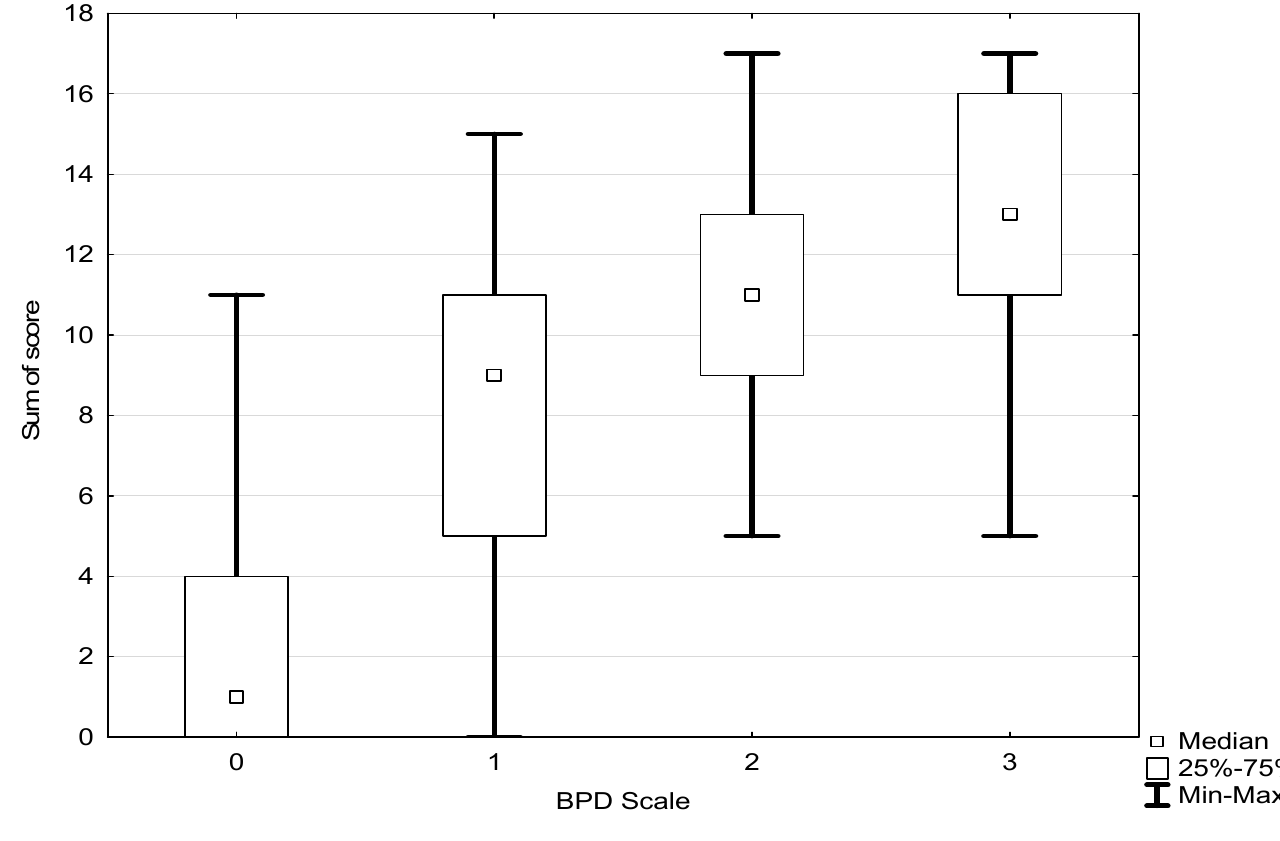
Figure 4. The severity of bronchopulmonary dysplasia in particular risk